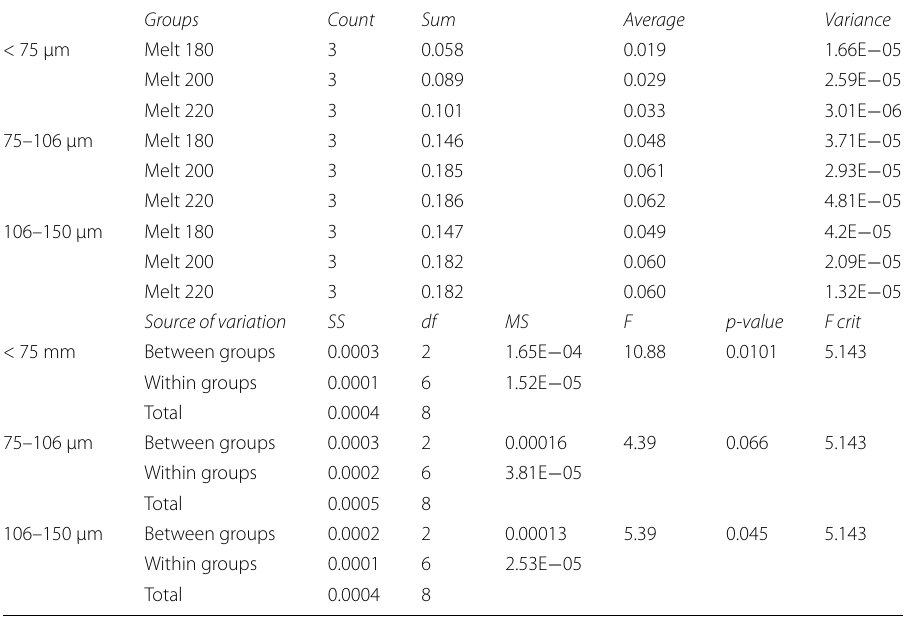
Table 4 One-way ANOVA results for shrinkage: effect of injection temperature Groups Count Sum Average